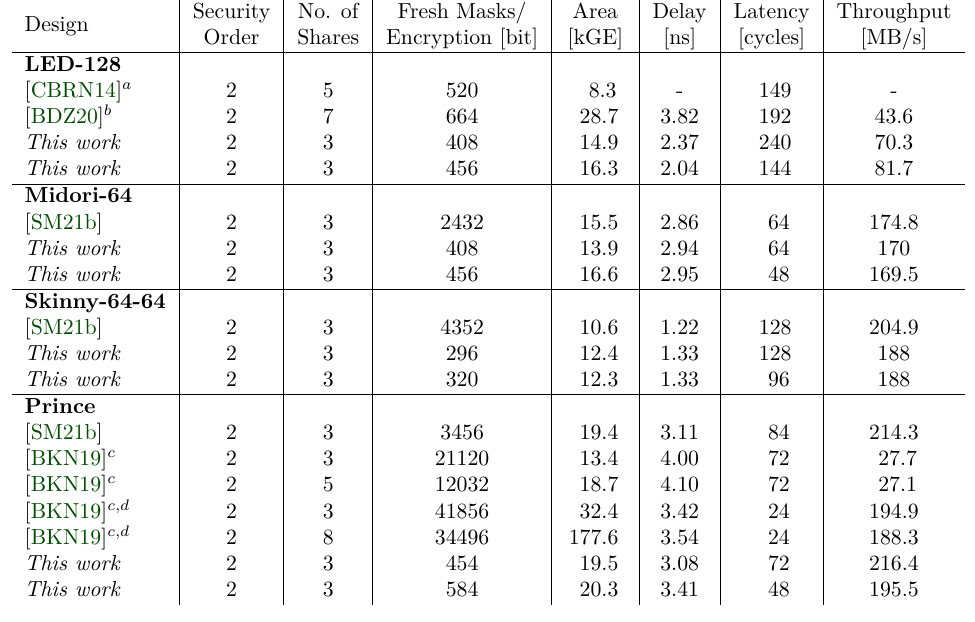
Table 1: Performance figures of different